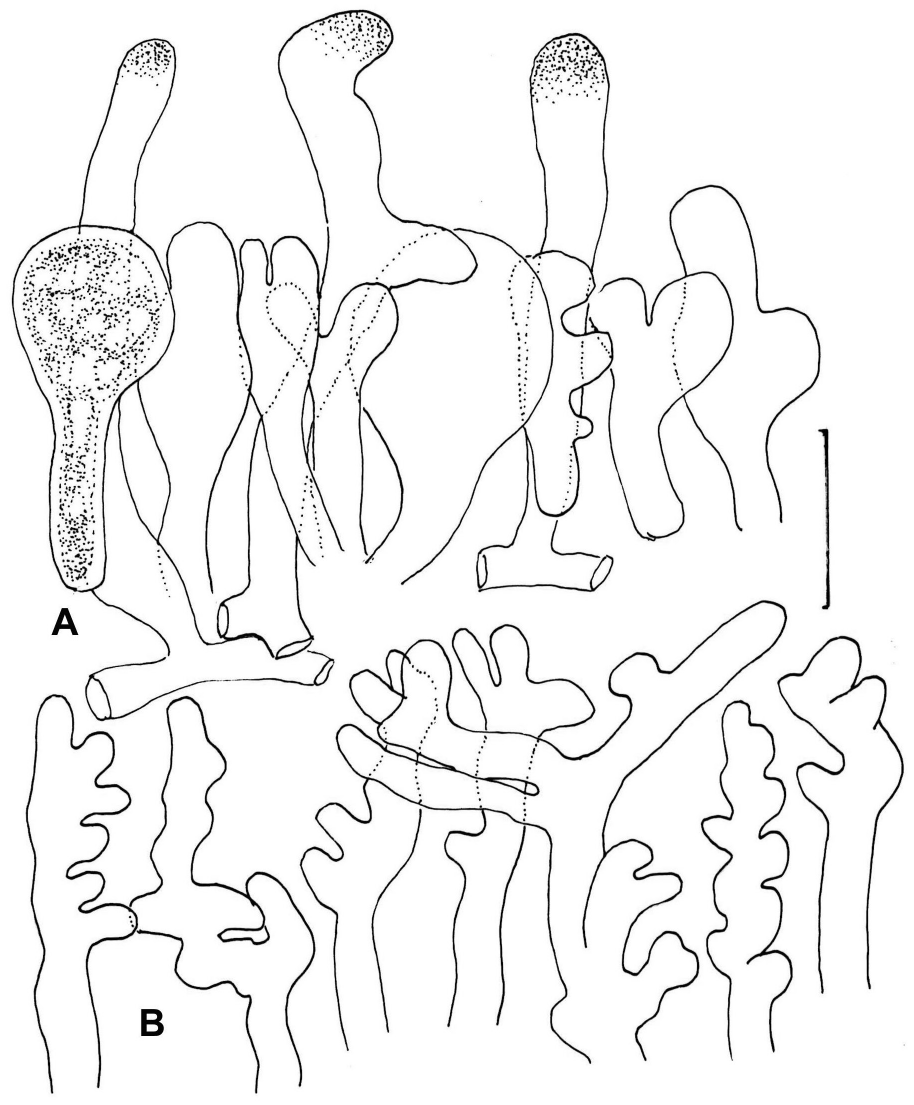
Figure 87. Mycetinis yunnanensis . Pileipellis structures. A Pileipellis structures of pileus disc B Diverticulate hyphae of pilus margin. Standard bars = 10 µm. TFB 3103